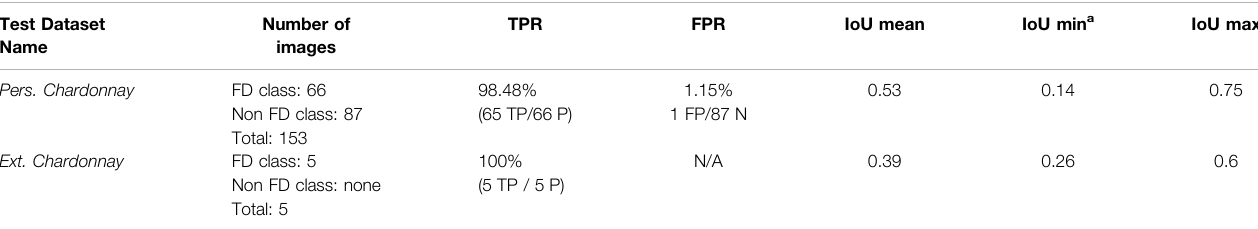
TABLE 3 | Summary of inference results on both Chardonnay datasets, presenting the True Positive Rate (TPR), False Positive Rate (FPR), mean, min and max values of Intersection over Union